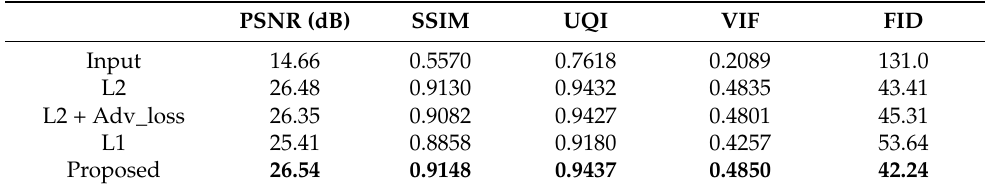
Table 6. Quantitative results for the noise level of sigma 50 compared with different loss functions. Bold results show good scores.